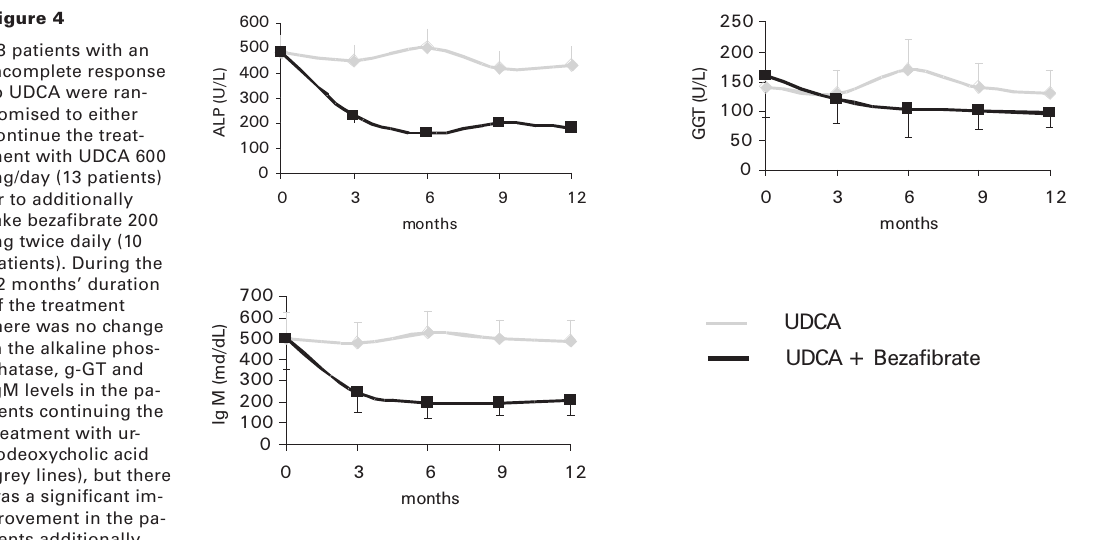
Figure 4 23 patients with an incomplete response to UDCA were ran- domised to either continue the treat- ment with UDCA 600 mg/day (13 patients) or to additionally take bezafibrate 200 mg twice daily (10 patients). During the 12 months’ duration of the treatment there was no change in the alkaline phos- phatase, g -GT and IgM levels in the pa- tients continuing the treatment with ur- sodeoxycholic acid (grey lines), but there was a significant im- provement in the pa- tients additionally taking in bezafibrate (black lines). (adapted from